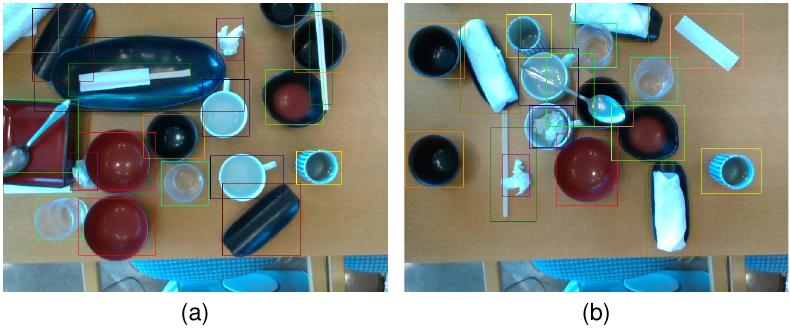
Figure 5. Examples of detection results on FPGA. ( a ) first example, ( b ) second